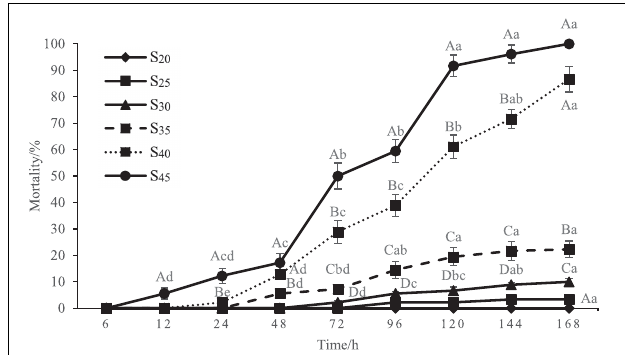
FIGURE 2 | Mortality rate of Sinonovacula constricta at different salinities and time points. Different capital letters represent significant differences between groups treated with different salinity levels at the same time point ( P < 0.05), and different small letters represent significant differences between different time points for the same group ( P <